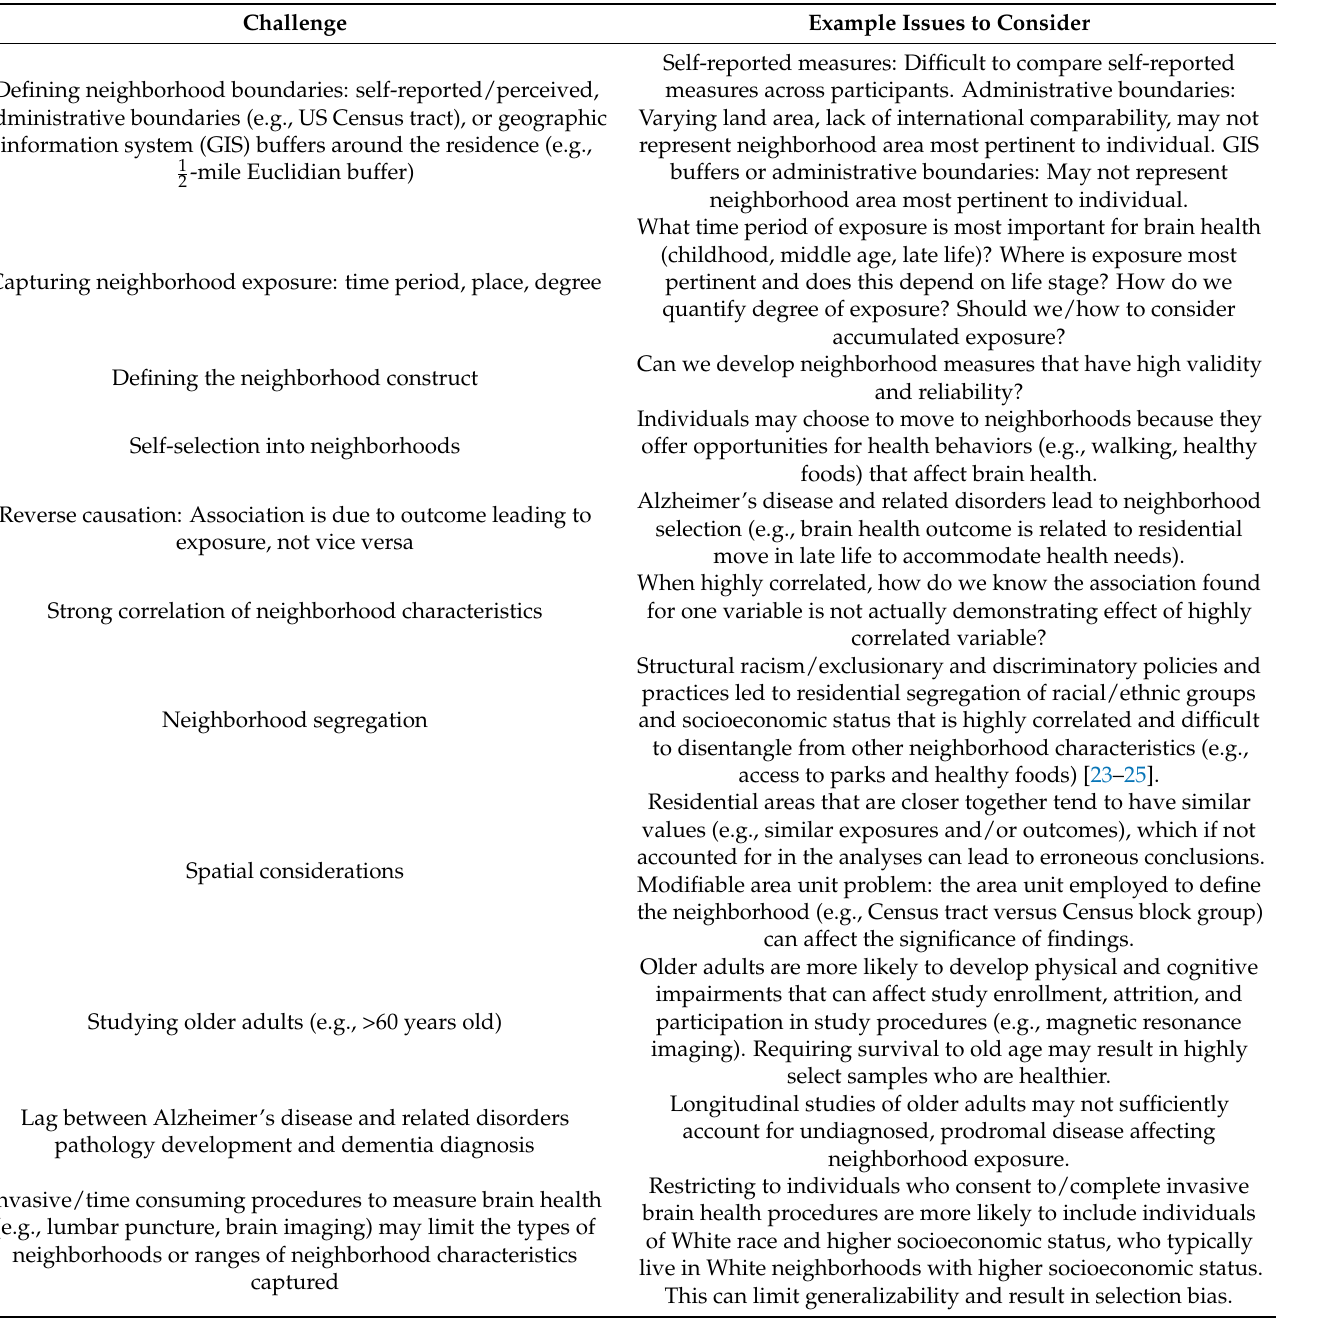
Table 1. Select methodological challenges of research on neighborhood environments and brain